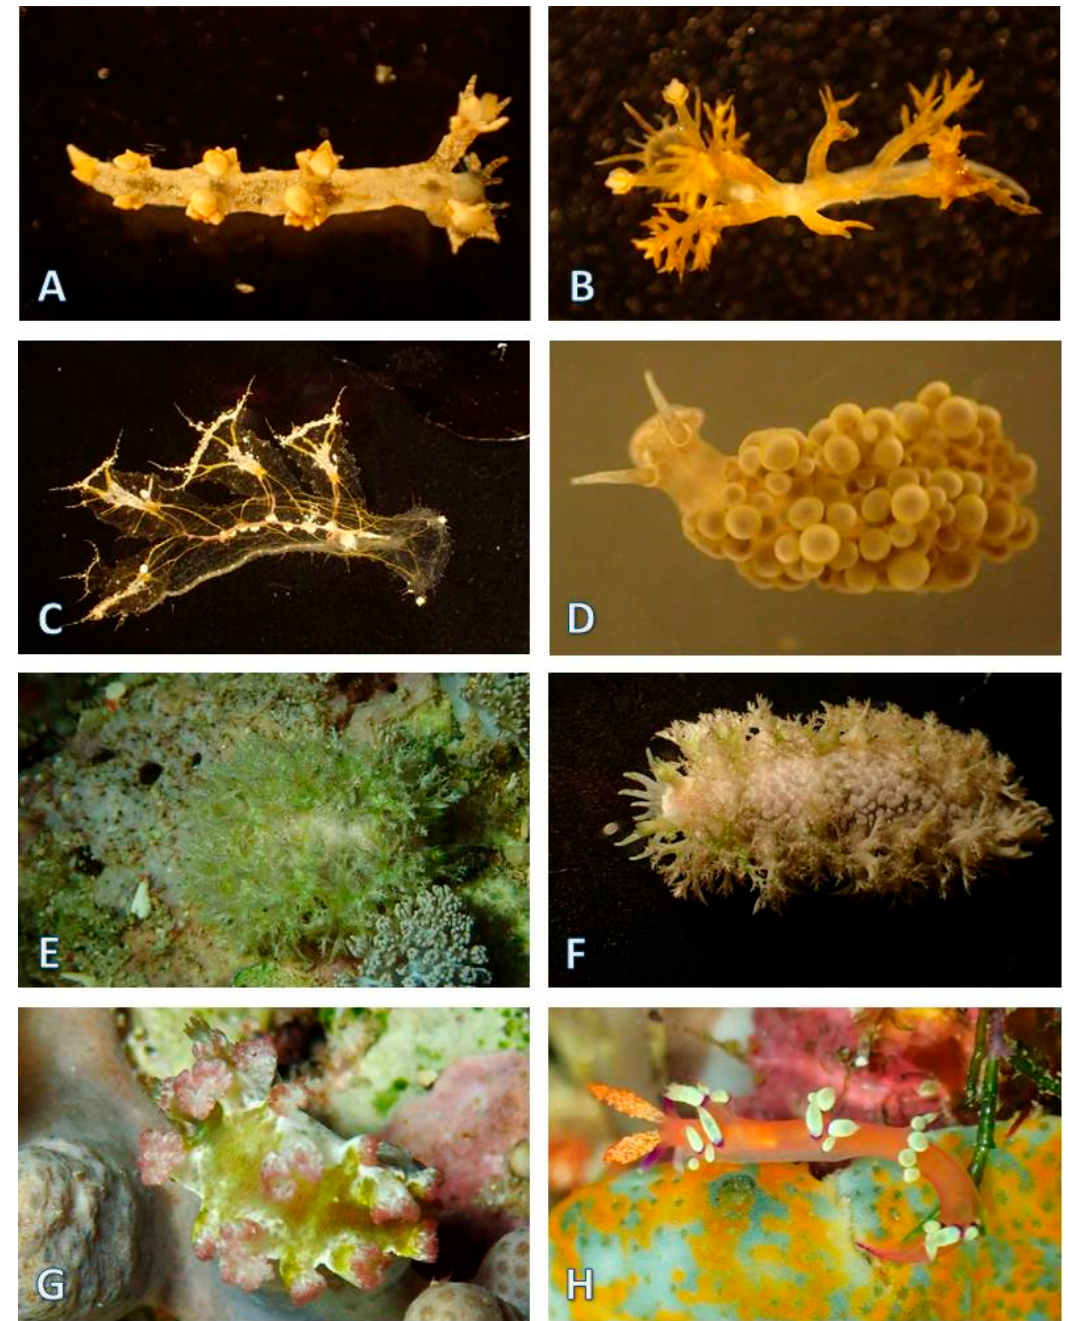
Figure 20. Nudibranchia Cladobranchia: ( A ) Bornella dotoides , Bohe18Ba-1; ( B ) Melibe bucephala , Mesp.a18Ba-1; ( C ) Melibe engeli , Mebu18Ba-1; ( D ) Doto ussi , Dous18Ba-2; ( E , F ) Marionia sp. ( Marionia sp. 2 in Gosliner et al. [24]: 324), Masp2.18Ba-1 ; ( G ) Tritonia sp. ( Tritonia sp. 3 in Gosliner et al. [24]: 320), Trsp3_17Ba-1; ( H ) Coryphellina exoptata, Flex17Ba-1 .